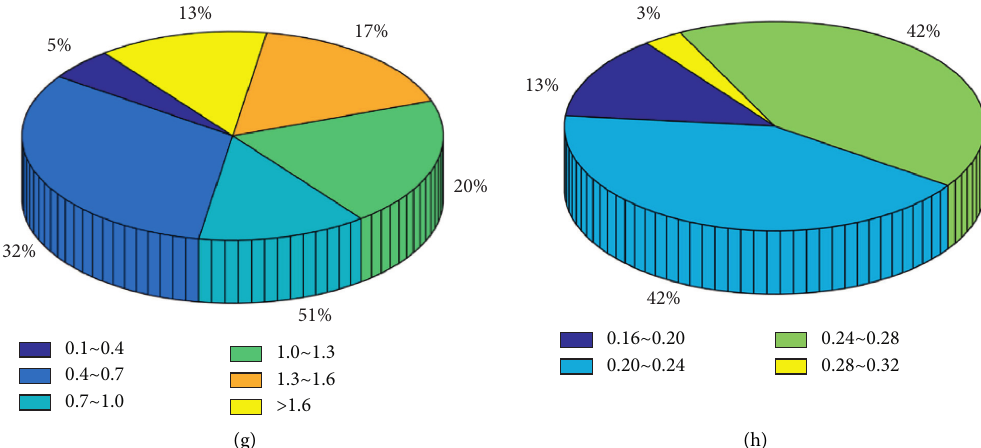
Figure 3: Distribution of each parameter: (a) the distribution of concrete strength, (b) the distribution of FRP stiffness, (c) the ratio of sheet length to beam length, (d) the ratio of sheet width to beam width, (e) the shear-to-span ratio, (f) longitudinal reinforcement ratio, (g) stirrup reinforcement ratio, and (h) the yield strain of steel bars.